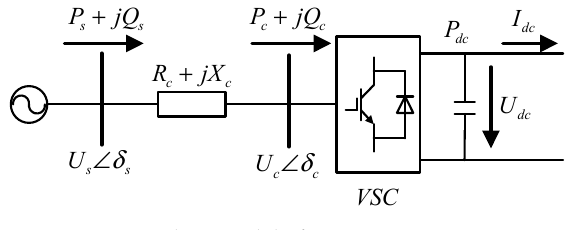
Figure 1. Equivalent model of VSC.